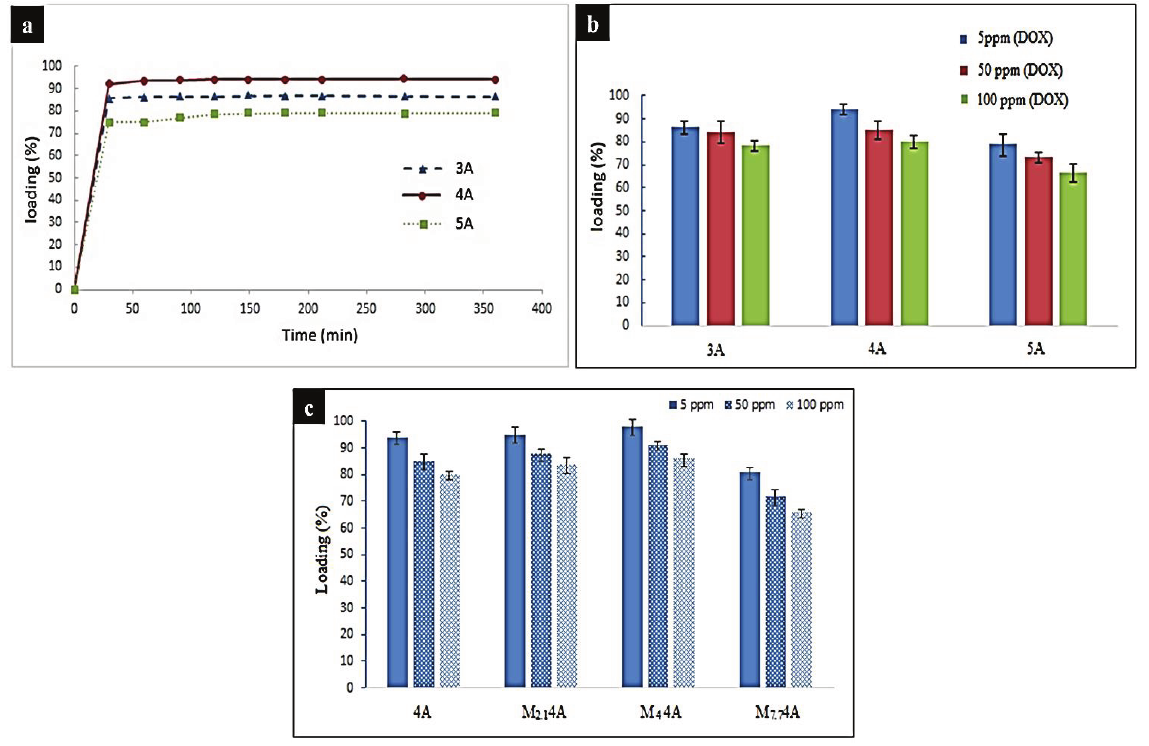
Figure 4: Drug loading efficiency of a) 3A, 4A &5A; b) A type zeolites with different amounts of DOX; c) 4A and M n 4A for diff erent amounts of DOX